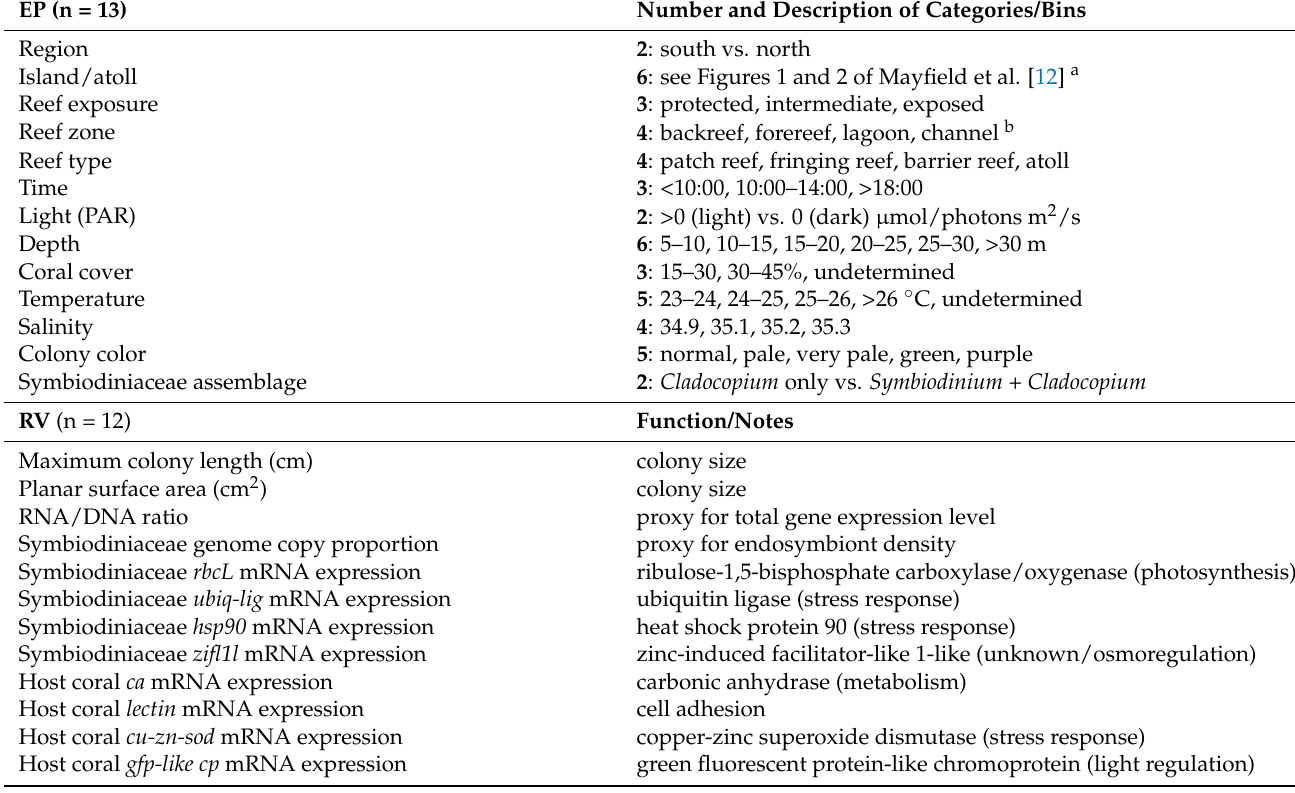
Table 1. Environmental parameters (EP) and coral response variables (RV) measured. Please note that the first two RV were not generally featured in the statistical models. PAR = photosynthetically active